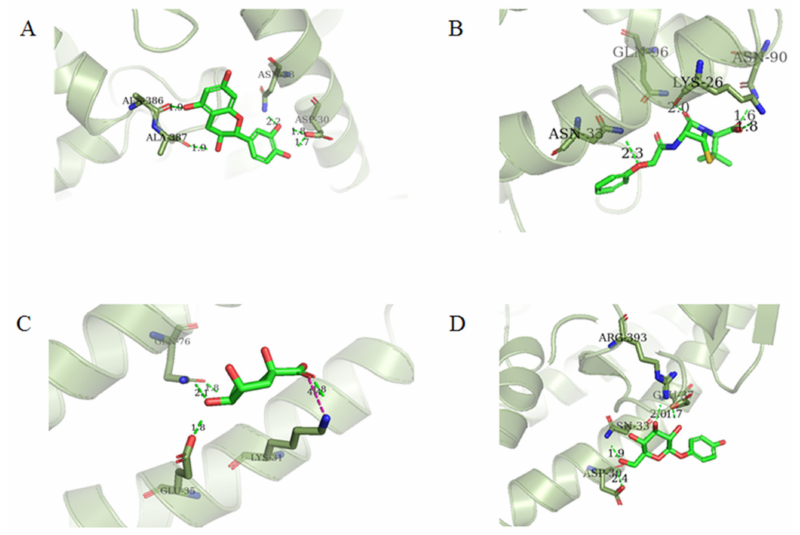
Figure 3. The interaction details of four potential compounds with ACE2. ( A ) 154-23-4; ( B ) 132-98-9; ( C ) STOCK1N − 53429; and ( D ) STOCK1N-07141. The green lines show hydrogen bonds, and the purple line shows salt